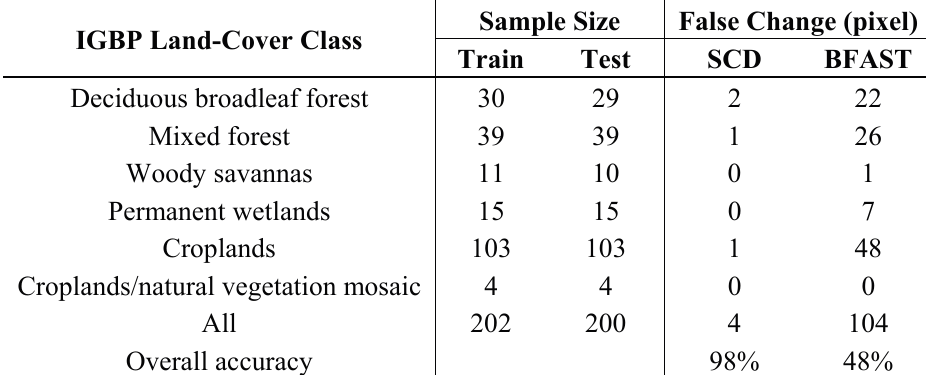
Table 2. Summary of the results for the stable